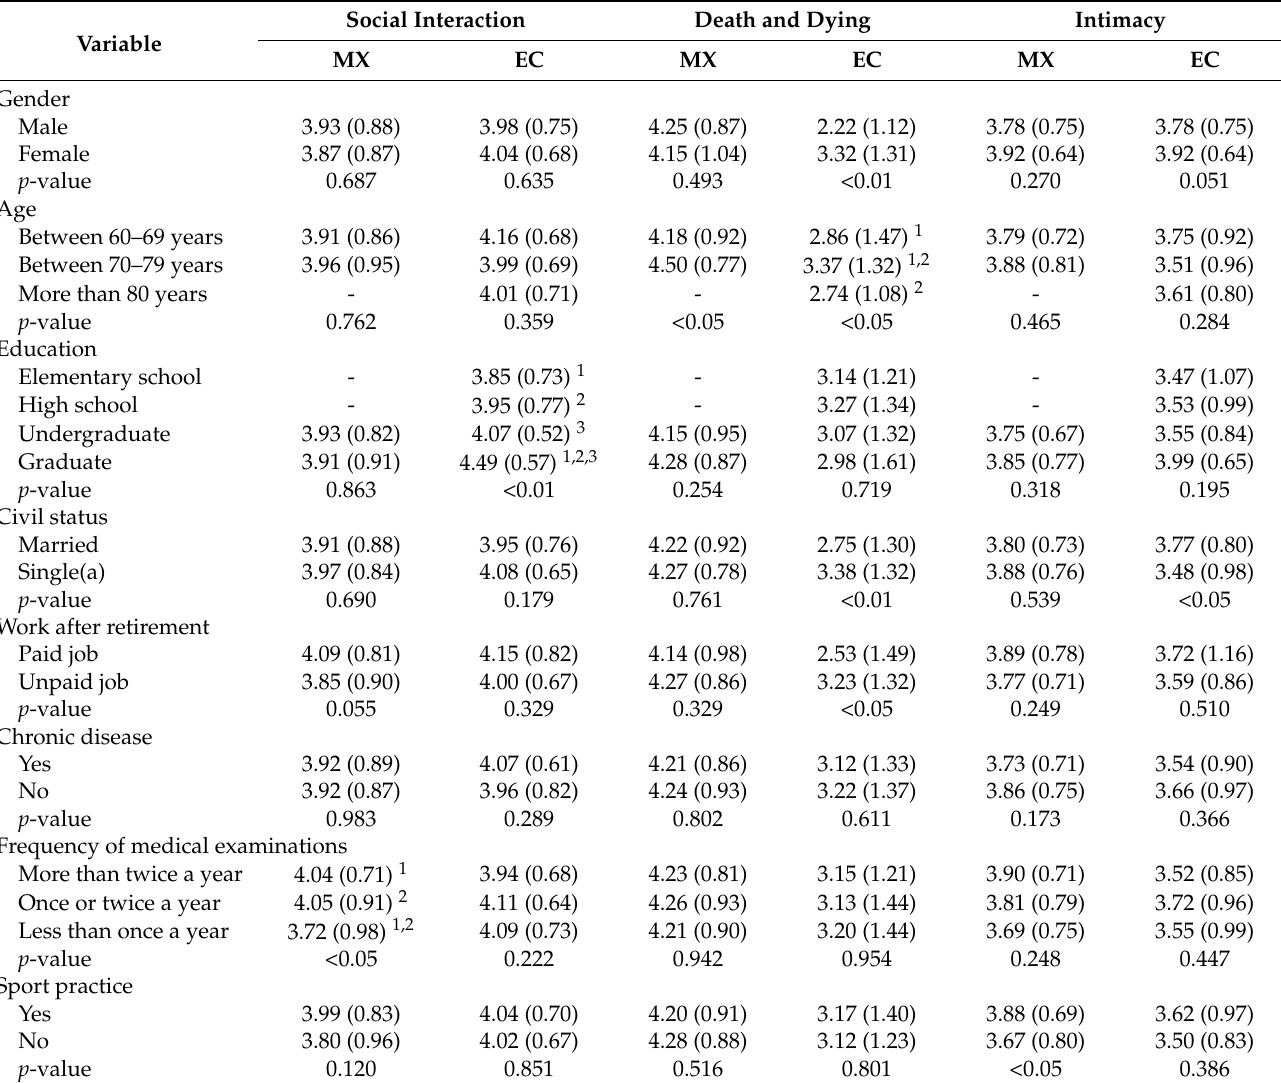
Table 3. Mean comparison of the WHOQOL-OLD dimensions among countries by sociodemographic characteristics. Second